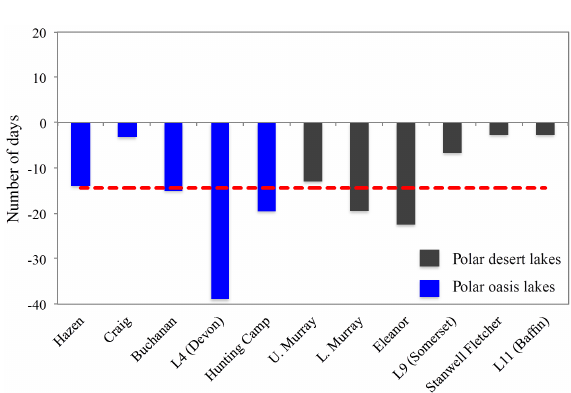
Figure 4. Changes – shown as number of days – in the melt on- set date of investigated lakes in the central and eastern Canadian High Arctic (1997–2011). Number of days change is reported rel- ative to the 1997–2011 mean melt onset day derived from space- borne observations during this period. Lakes in polar-oasis environ- ments are shown as blue bars and lakes in polar-desert environments are shown as grey bars. The red line indicates the 1997–2011 mean number of days change for melt